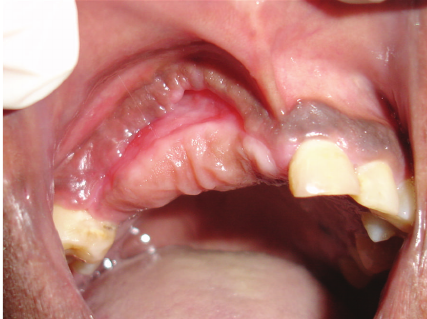
Figure 2: Gross specimen (sequestrum) obtained during surgery (occlusal view); note palatal and interradicular bone destruction.